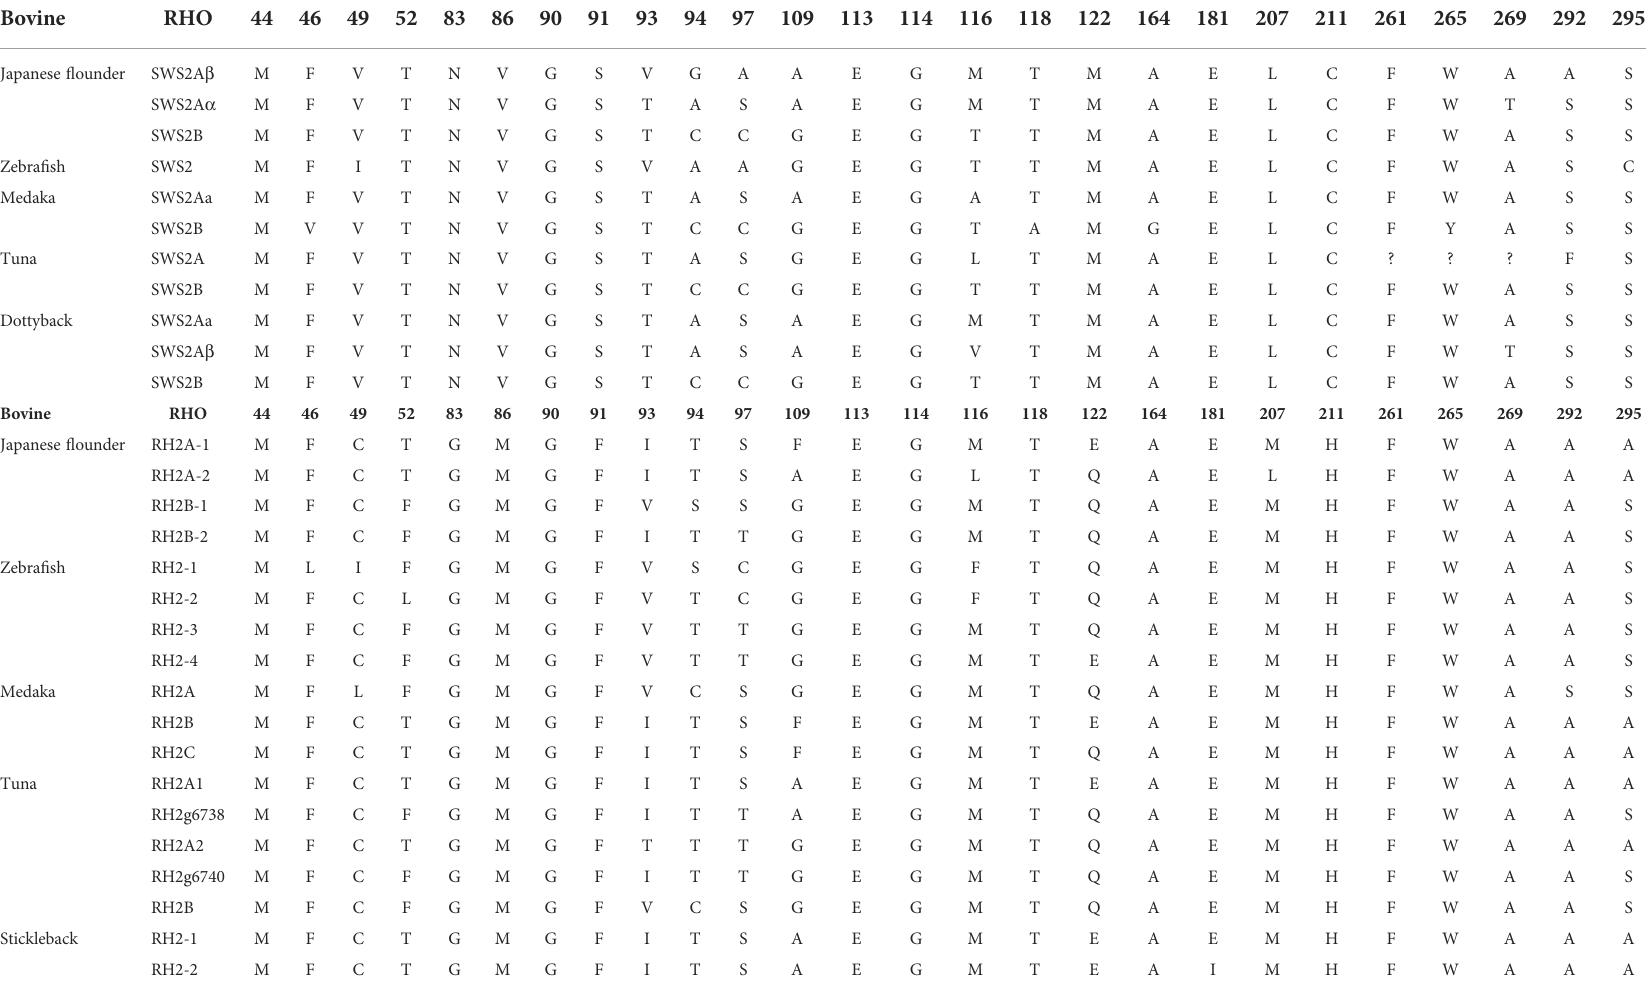
TABLE 2 Comparison of the representative amino acid sites involved in the light sensitivity of SWS2 and RH2 opsins among several teleosts*. Bovine RHO Japanese fl ounder